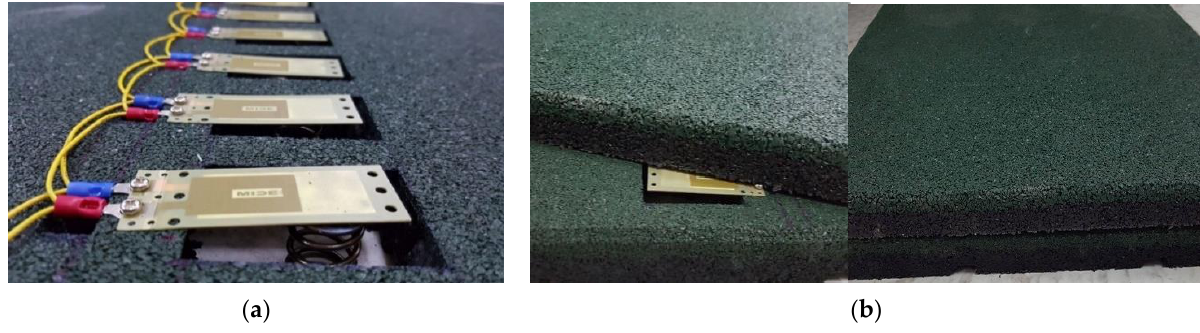
Figure 8. The material used and the piezoelectric installation area: ( a ) piezoelectric module installa- tion; ( b ) surface material for bike lane. Table 3. List of piezoelectric material properties.